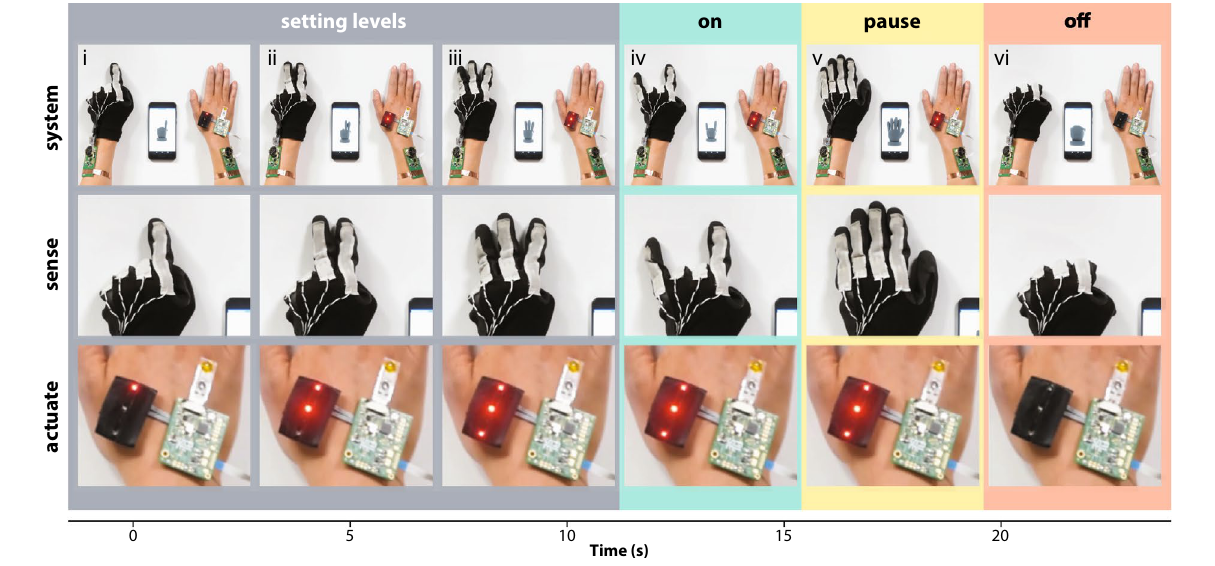
Figure 4. Demonstration of the digital nervous system (DNS) proof-of-concept. Time-lapse and corresponding image panels (system overview, sense and actuator nodes; Supplementary Movie 1) displaying: setting the drug dispensing levels by counting to three ( i – iii ), pump activation by ‘rocker’ gesture ( iv ), pausing ( v ), and clearing the system (vi) and associated LED array responses next to an inserted ion pump. Photographs taken by Thor Balkhed at Linköping University, and used with